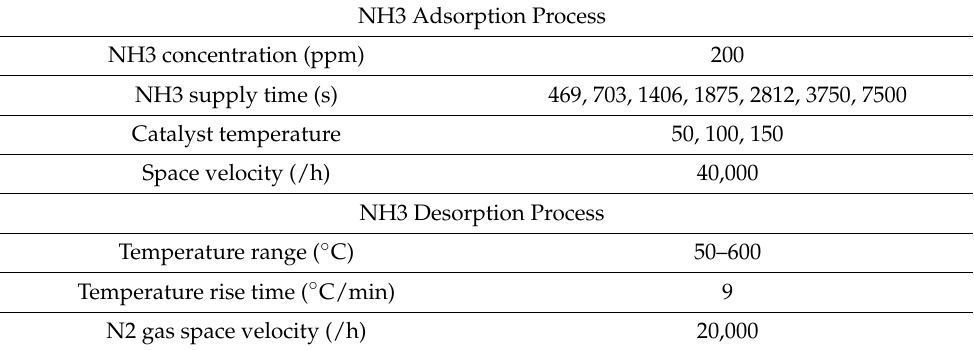
Table 3. Experimental